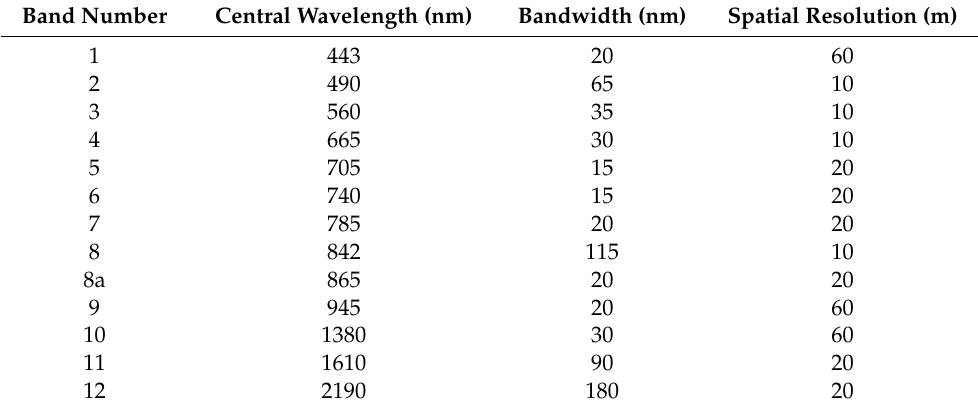
Table 1. Spectral bands of Sentinel–2